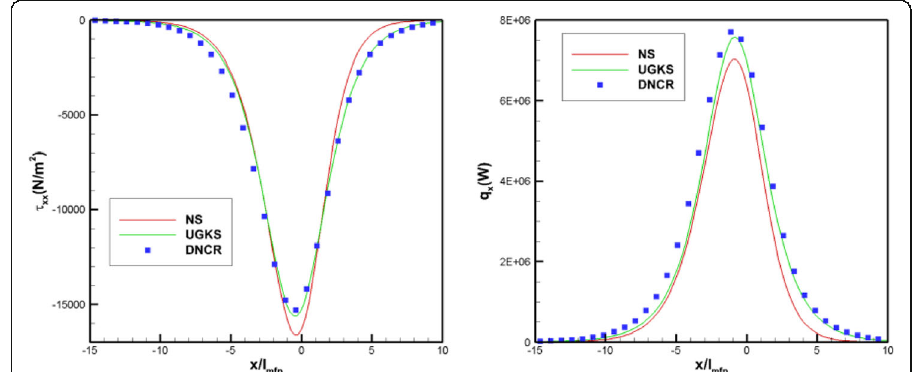
Fig. 3 Comparisons of stress τ xx and heat flux q x in shock structure using the NS, UGKS and DNCR at Mach 1.6